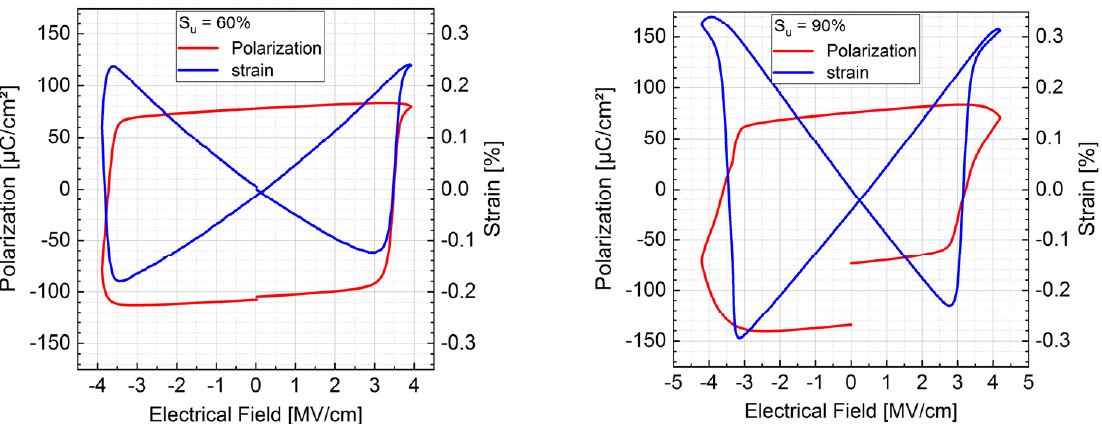
Figure 8. DBLI measurement of polarization and strain of 1µm Al 0.695 Sc 0.295 N deposited with pulse mode S u = 60% ( left ) and S u = 90% ( right ) on Ti/Pt seed layer with Ø0.75 mm Al top electrode (= 0.44 mm²) depending on electrical field, measured at 1 kHz, average of 100 measurements.